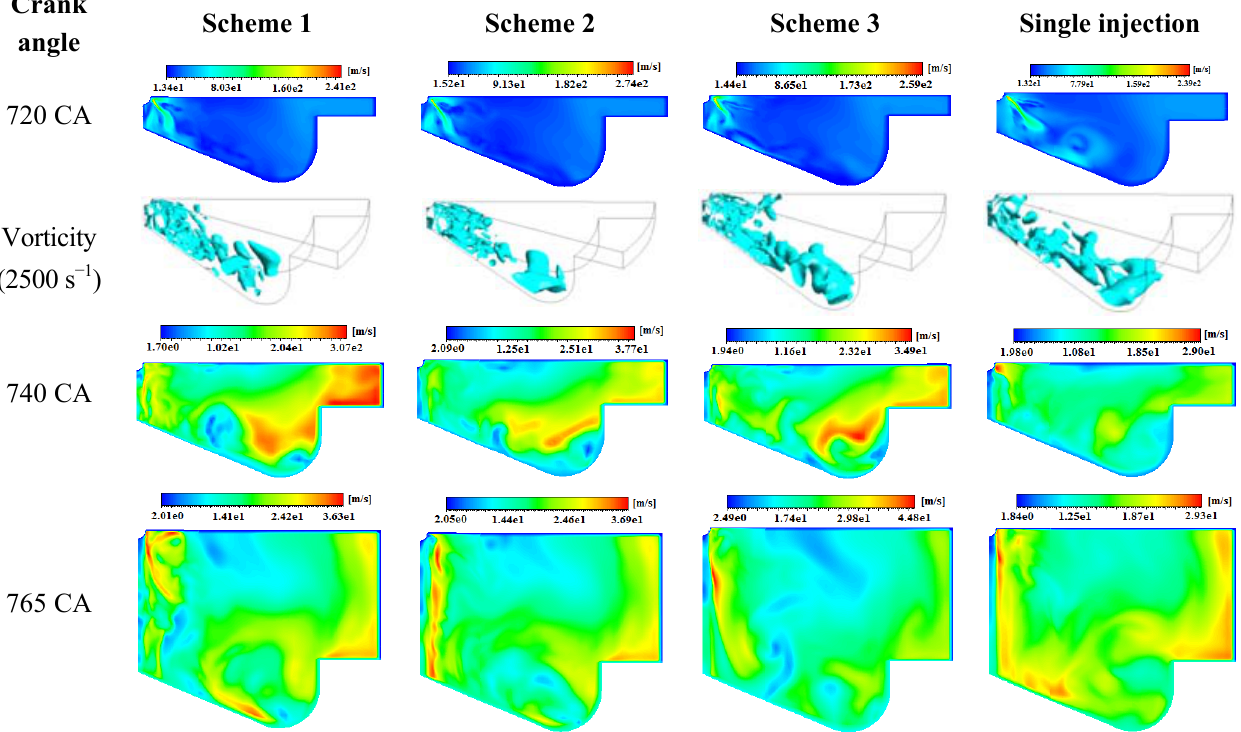
Figure 12. Velocity field contours for the best cases in comparison with the single injection